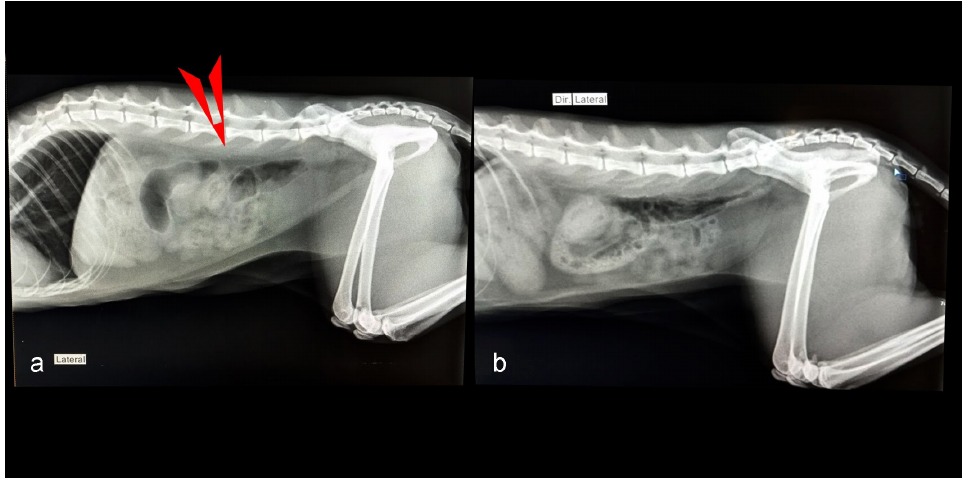
Figura 4. Imagem radiológica abdominal lateral realizada antes e durante o tratamento. (a) Imagem revelou imagem radiopaca (seta) em ureter distal compatível com ureterolitíase; (b) Imagem após terceira aplicação de glucagon não evidenciou